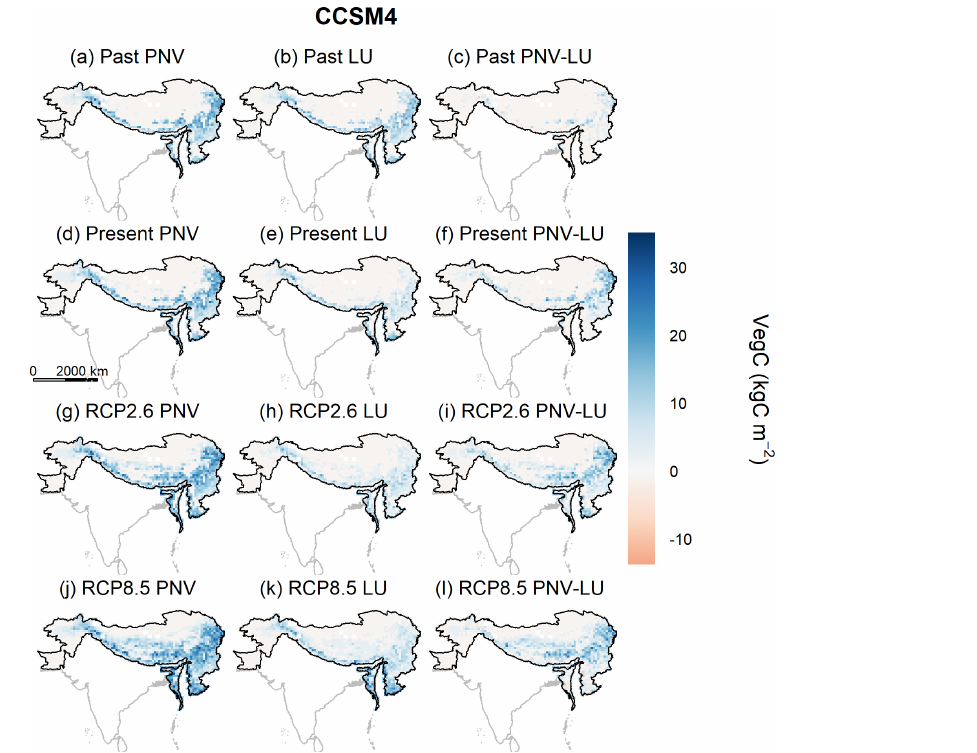
Figure 8. LPJ-GUESS-simulated distribution by CCSM4 on VegC in HKH region under the (a) past period (1851–1880) with PNV, (b) past period (1851–1880) with land-use change, (c) difference between past PNV and past LU, (d) present period (1986–2015) with PNV, (e) present period (1986–2015) with land-use change, (f) difference between present PNV and past LU, (g) future scenario RCP2.6 (2071–2100) with PNV, (h) future scenario RCP2.6 with LU (2071–2100), (i) difference between future RCP2.6 PNV and LU, (j) future scenario RCP8.5 (2071–2100) with PNV, (k) future scenario RCP8.5 with LU and (l) difference between future RC8.5 PNV and